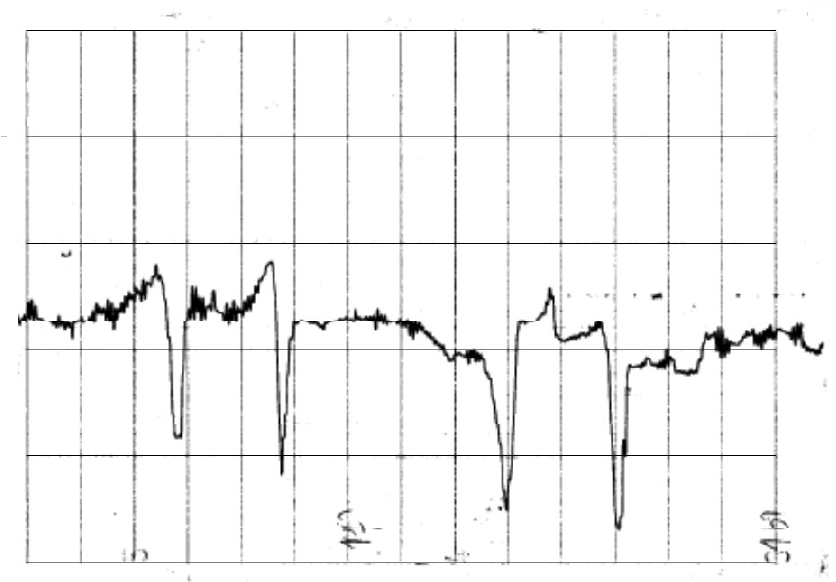
Figure 3. A fragment of recording tape recorder showing 4 passes of a dielectric object over the antenna module at H = 1.5 m and h = 1.5 m.